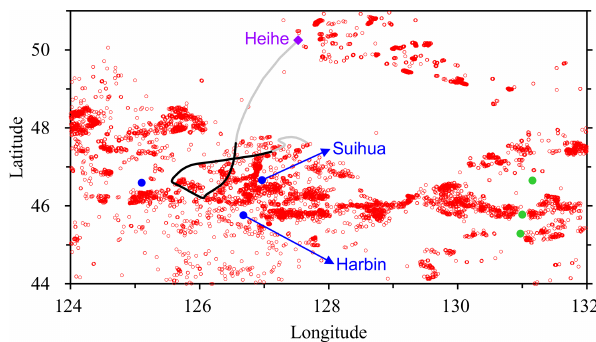
Figure 10. Active fires (red circles) detected by the joint NASA/NOAA Suomi National Polar-orbiting Partnership (S-NPP) satellite for Heilongjiang Province during 17–18 April 2020. Three cities located in the Songnen Plain are shown using blue dots (the unlabeled city is Daqing), and three cities located in the Sanjiang Plain (i.e., Shuangyashan, Qitaihe and Jixi with decreasing lati- tudes) are shown using green dots. The two plains, separated by mountains, are the main agricultural regions in Heilongjiang. In- tensive agricultural fires are evident for both plains during the 2d episode, indicating the open burning activities are province-wide, although prohibited. The agricultural fires resulted in severe PM 2 . 5 pollution for nearby cities, e.g., the 24h concentrations peaked at ∼ 900 and 675µg/m 3 in Harbin and Jixi, respectively. A PM episode was observed even for Heihe ( ∼ 500km away from Harbin) on 19 April 2020, which was attributed to the pollutants trans- ported from the Harbin–Suihua region. The solid line indicates the 72h back trajectory ending at 07:00 in Heihe, accompanied with the highest 1h PM 2 . 5 observed on 19 April 2020 ( ∼ 310µg/m 3 ). The trajectory indicates transport pathway of air masses impact- ing Heihe, with the segment in black showing locations of the air masses during 17–18 April